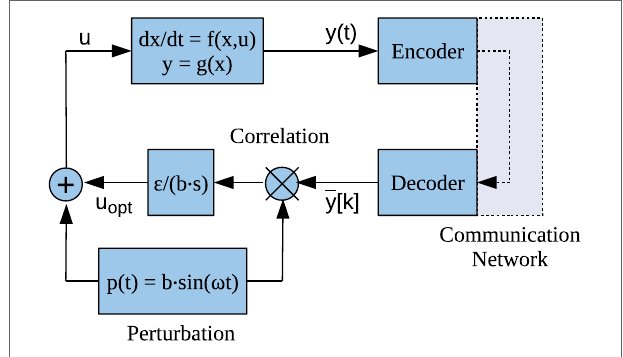
FIGURE 1 | Extremum seeking control with feedback over a communication network